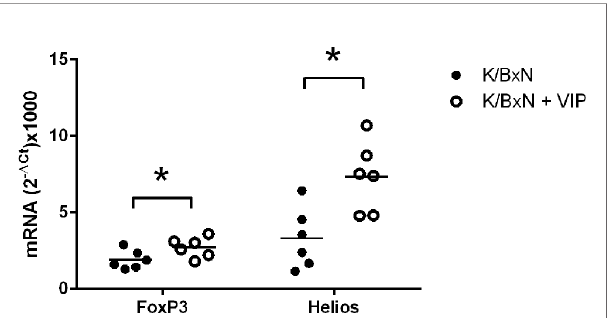
FIGURE 5 | Effect of VIP on mRNA expression of master transcription factors of Treg cells. The expression was determined by quantitative real- time PCR as indicated (supplemental materials). Mean is shown as the horizontal line within each group; each symbol represents an individual mouse. *p <